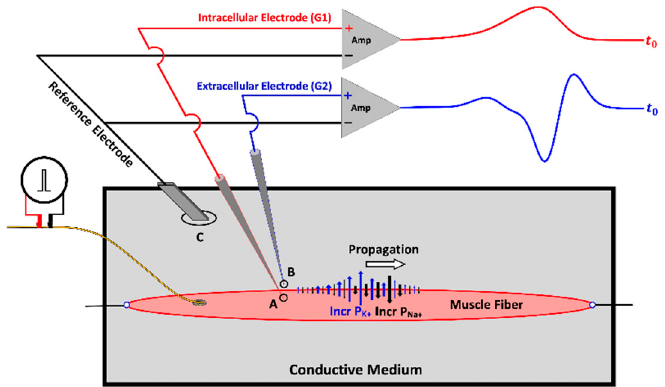
Figure 2. Differential amplification of the intracellular (A) and extracellular recordings (B). The reference electrode (C) in this figure is also the ground; it records the magnitude of the offset potential of the conductive medium that is used to compare the intracellular and extracellular potentials. The blue arrows indicate increased permeability for potassium ions (P K+ ) and black arrows indicate increased permeability for sodium ions (P Na+ ). G1 records the intracellular potential while G2 records the extracellular potential. The positive sign for both G1 and G2 denotes that the inputs are unaltered. The reference electrode is connected to the inverting inputs of the amplifiers because it represents the offset that is subtracted from the G1 and G2 inputs.